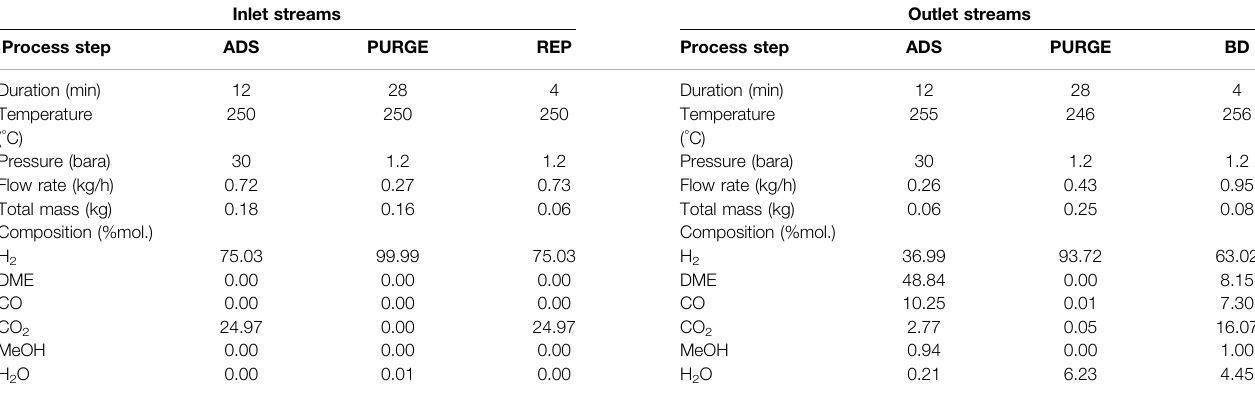
TABLE 5 | Conditions and compositions of the inlet and outlet streams simulated using the dynamic cycle model for a single 0.008 m (Olah et al., 2009) reactor tube. Inlet